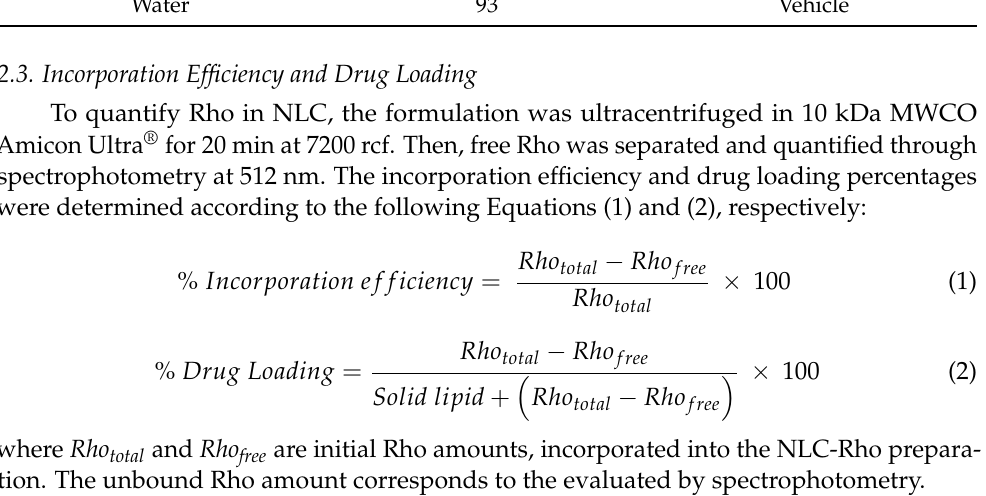
Table 1. Raw materials to fabricate the selected nanostructured lipid carrier (NLC) formulation. Raw Materials % p/p Components Role 4 Solid lipid (Gelucire ® 44/14) Lipid Liquid lipid (Miglyol ® 812)